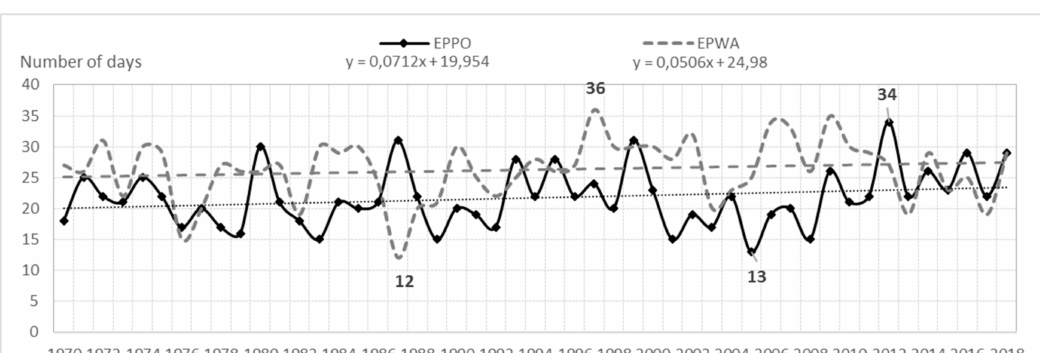
Figure 2. Average annual number of storm days and a linear trend in EPPO and EPWA